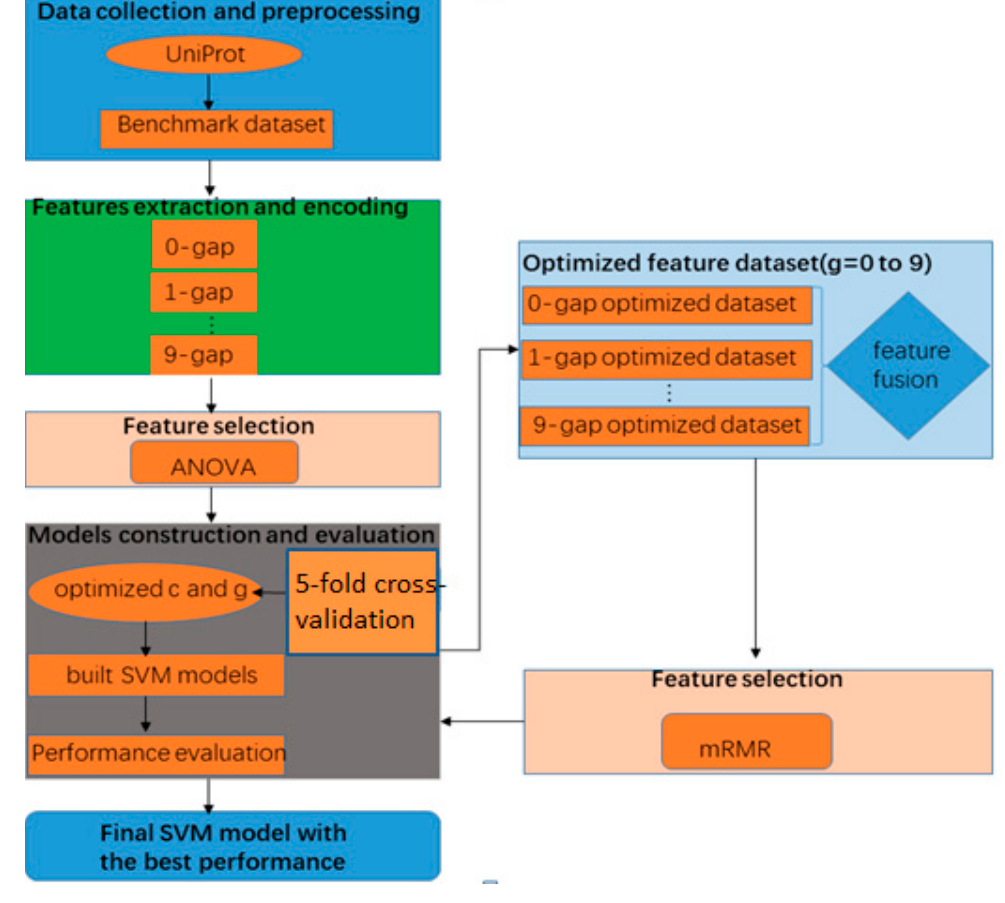
Figure 1. The framework of the proposed method.